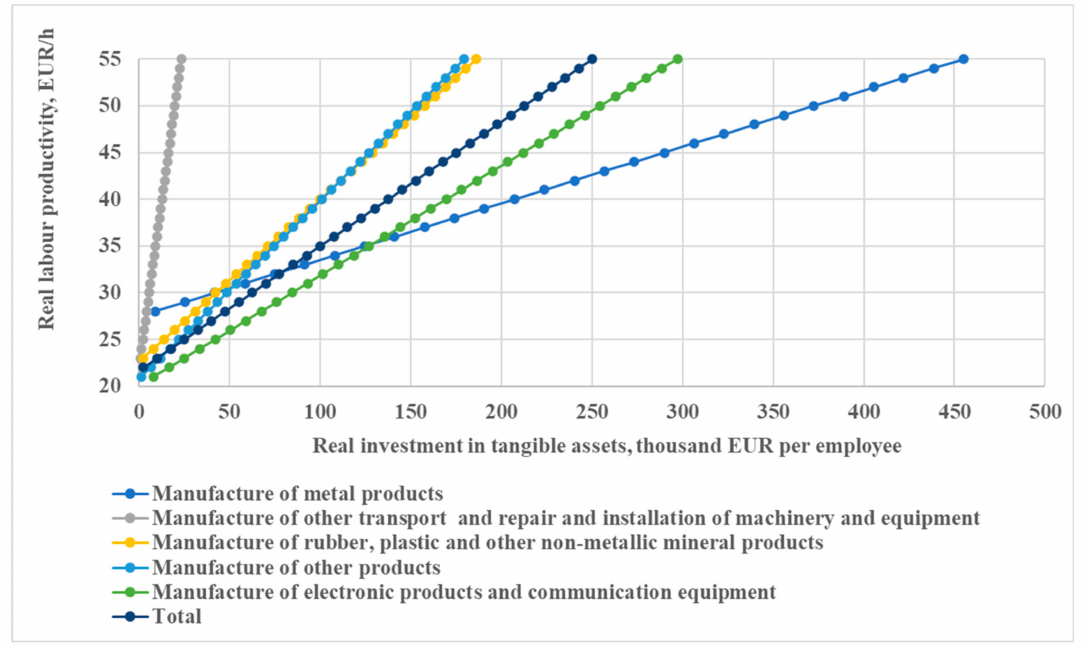
Figure 11. Linear curves of labour productivity to tangible investment (own